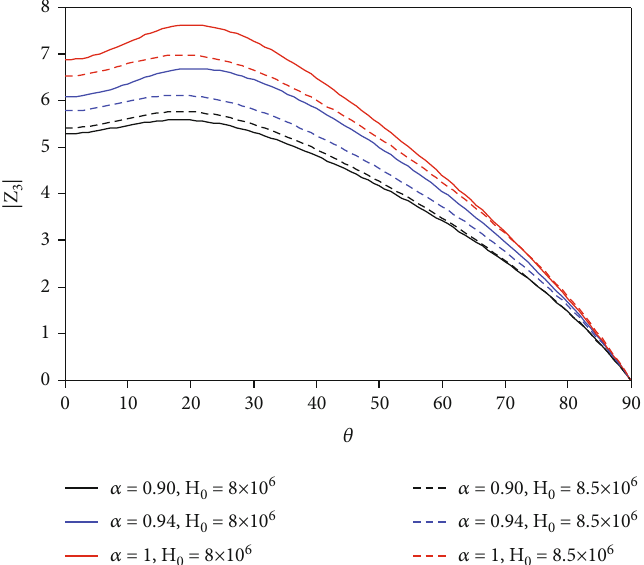
j concerning the angle of incidence θ for various values of the fractional parameter of the 3